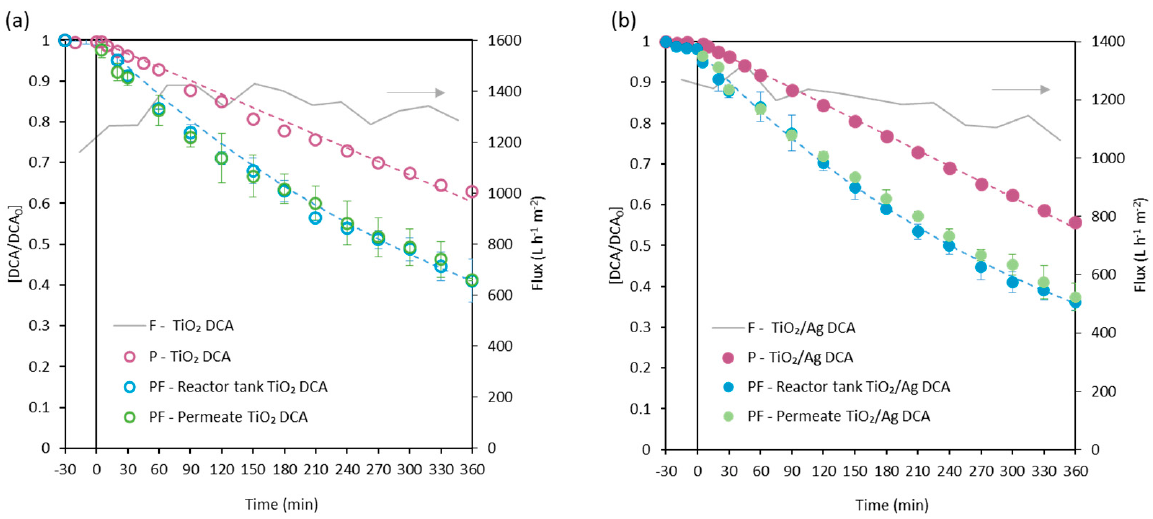
Figure 6. Comparison of DCA degradation in photocatalytic submerged membranes (P: photo- Figure 6. C omparison of DCA degradation in photocatalytic submerged membranes (P: photocata- catalytic experiments) and coupled photocatalysis and flow-through permeation experiments (PF: lytic experiments) and coupled photocatalysis and fl ow-through permeation experiments (PF: pho- photocatalytic and flow-through). Total flux, in grey lines, of flow-through permeation experiments tocatalytic and fl ow-through). Total fl ux, in grey lines, of fl ow-through permeation experiments at at a transmembrane pressure of 1 bar. ( a ) TiO 2 membrane and ( b ) TiO 2 /Ag a transmembrane pressure of 1 bar. ( a ) TiO 2 membrane and ( b ) TiO 2 /Ag membrane.